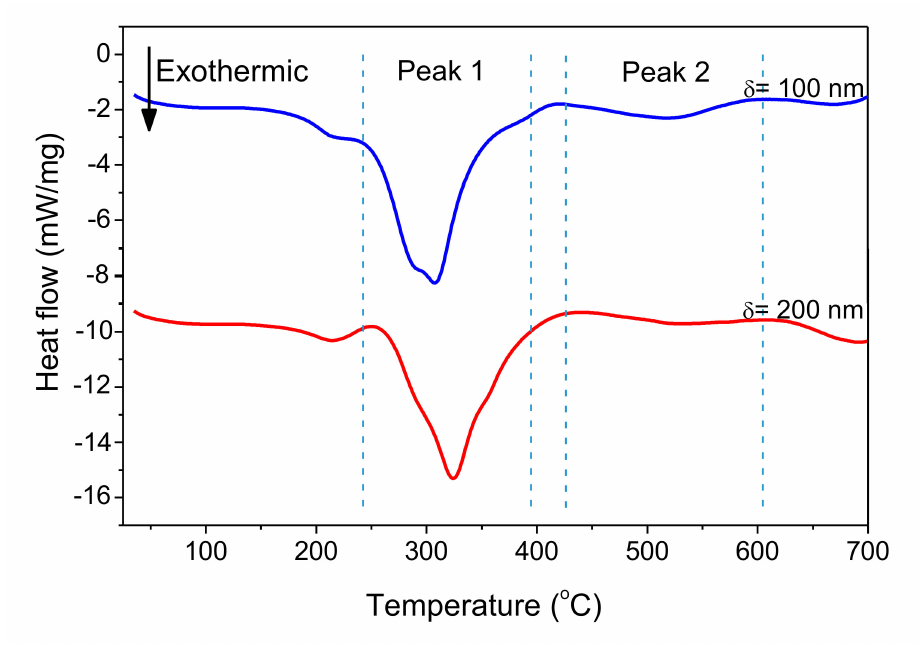
Figure 11. DSC curves of Pd/Al-iRMS with different bilayer